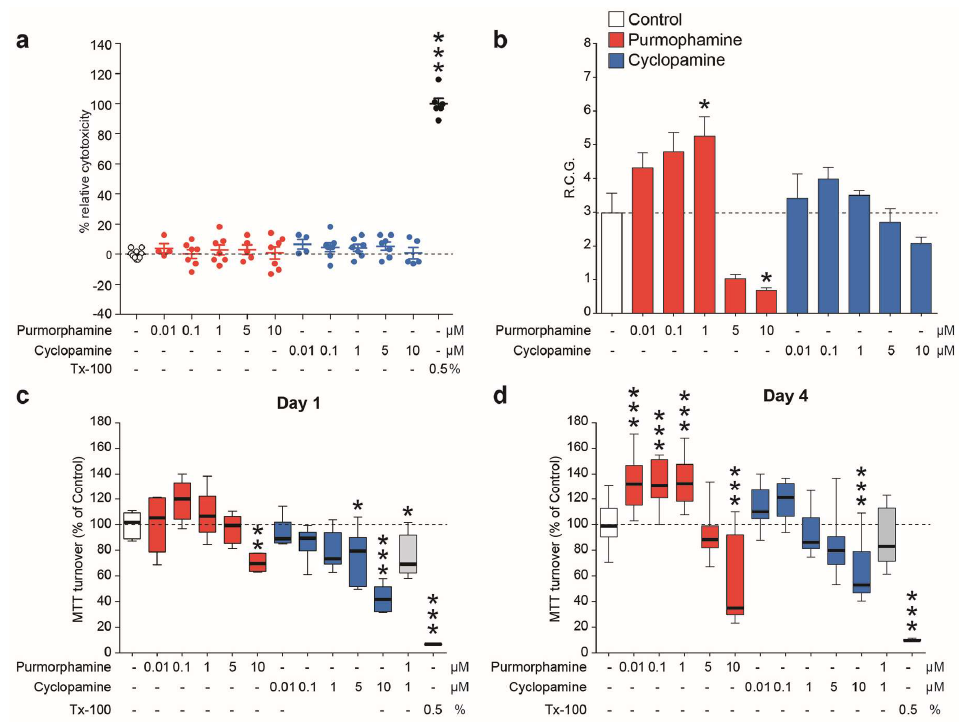
Figure 2. Purmorphamine activates sonic hedgehog (Shh) pathway within NSCs and increases the growth rate via activation of GLI-Kruppel family members 1 (Gli1). ( a ) Lactate dehydrogenase (LDH) viability assay on NSC cultures exposed to increasing concentration of purmorphamine and cyclopamine (0.01–10 µ M). Data are shown as dots plot and viability is calculated as percentage of control assumed as 0%. ( b – d ) Dosing of purmorphamine and cyclopamine (from 0.01 to 10.0 µ M) e ff ects on NSCs performed by evaluating the rate of cell growth (RCG) ( b ) and the 3-(4,5-dimethylthiazol-2-Yl)-2,5-diphenyltetrazolium bromide (MTT) turnover of NSCs cultured for 24 h ( c ) and 4 days ( d ) in the presence of Shh pathway modulators. Data are mean numbers ( ±